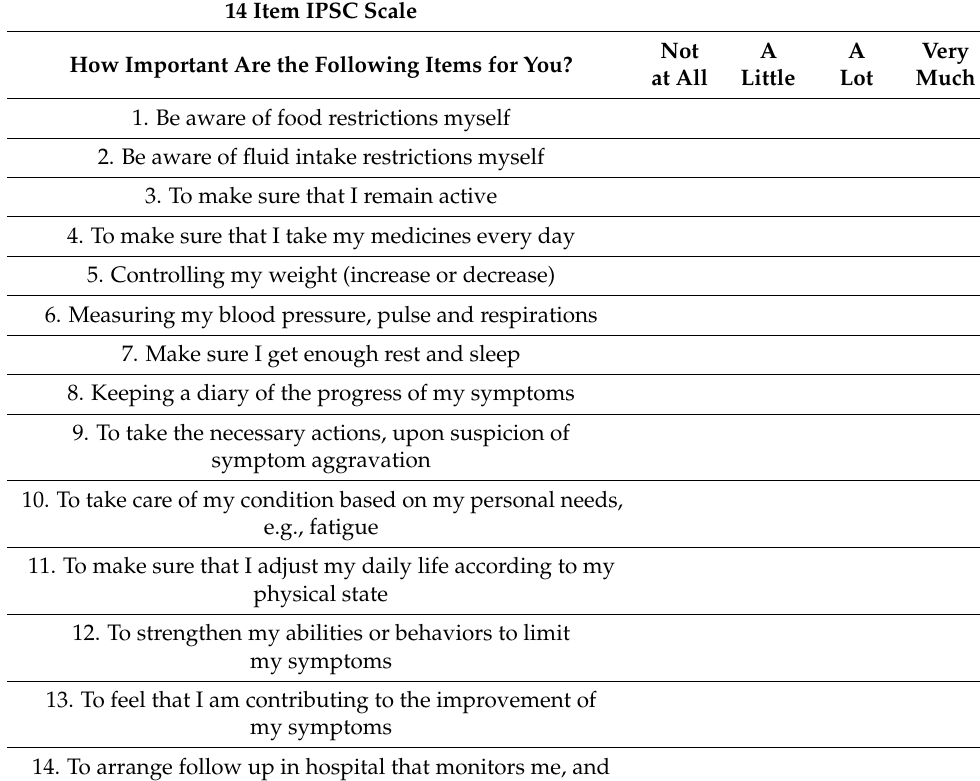
Table A1. 14 item IPSC